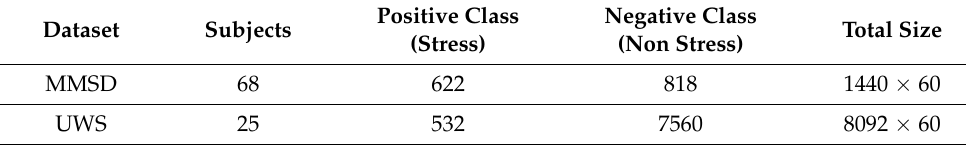
Table 2. Number of subjects and HRV windows for each